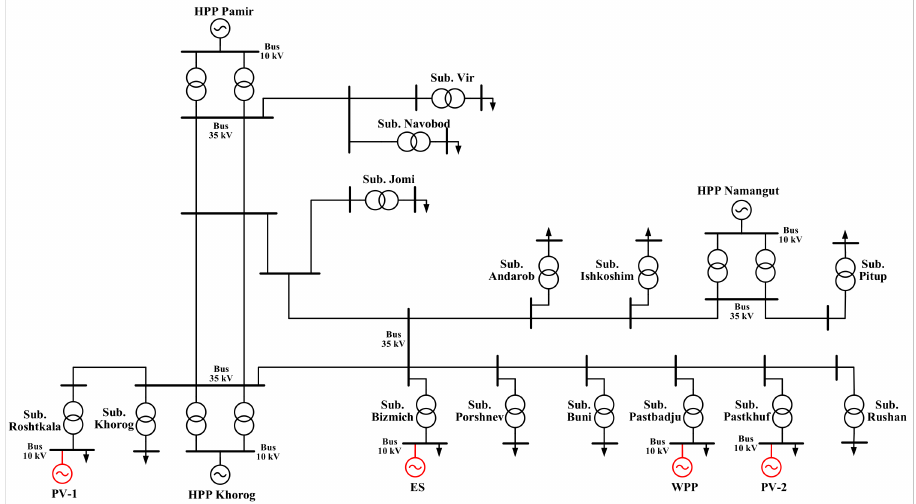
Figure 6. An electrical scheme of the considered autonomous power